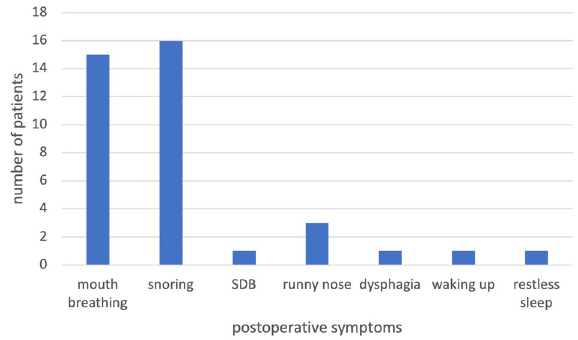
Figure 5. Persistent symptoms that were noted at the first postoperative follow up.